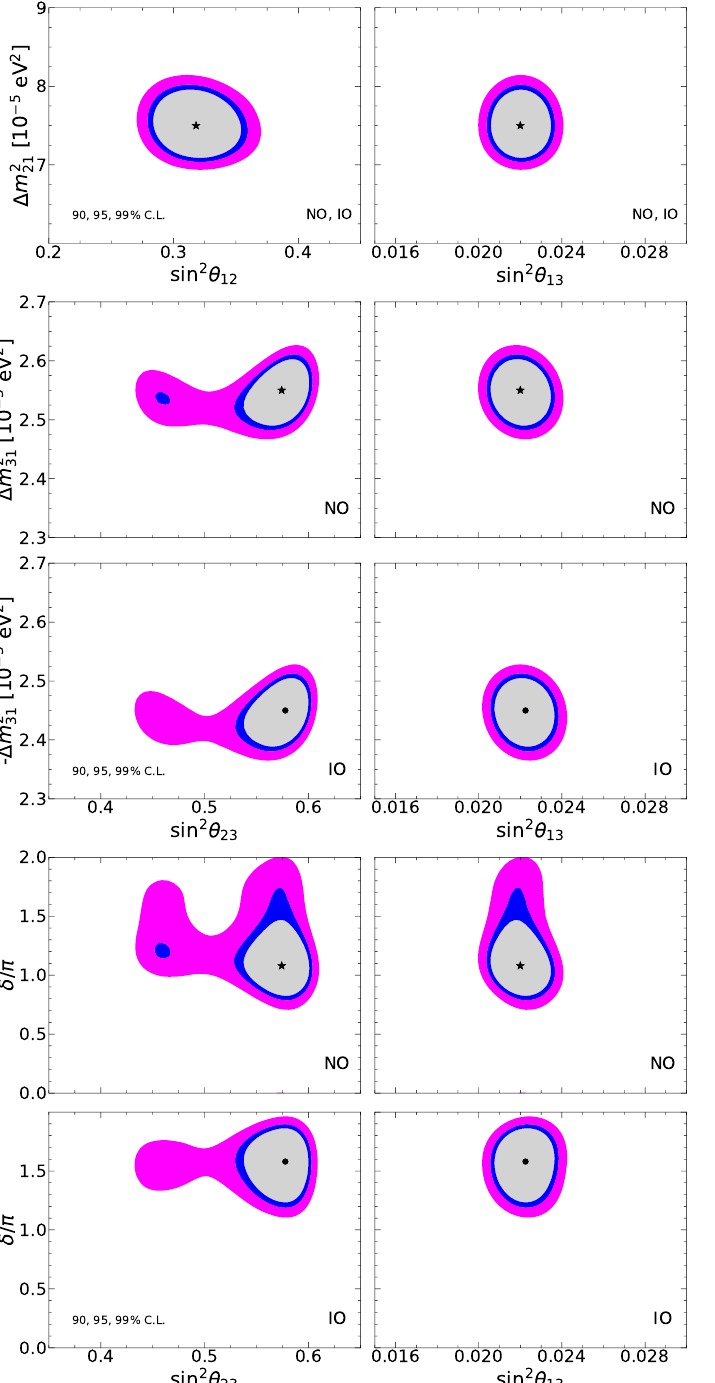
Figure 14 . Overall summary of our global fit to neutrino oscillation data. Global fit regions correspond to 90, 95 and 99% C.L. (2 d.o.f.). Regions for inverted ordering are plotted with respect to the local minimum in this neutrino mass ordering. The absolute minimum corresponding to NO is indicated by a star, while the local minimum in IO is denoted by a black